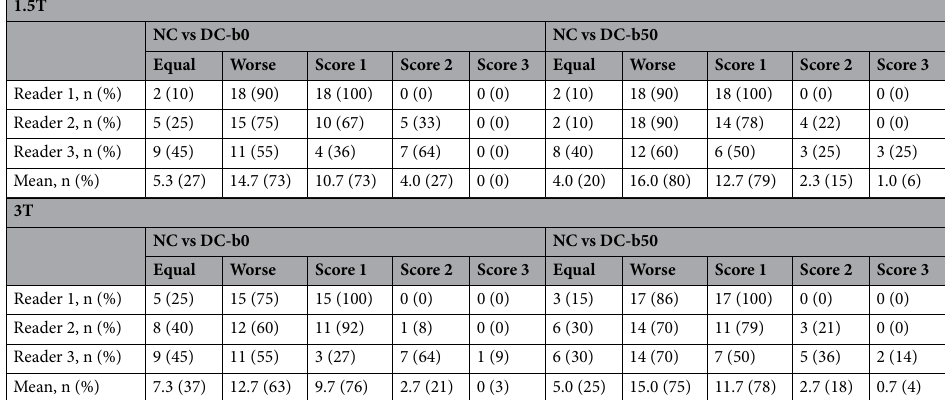
Table 4. Rating and scores given by three radiologists when comparing the image quality of non-corrected and distortion corrected axial b50 images side by side. The number of distortion corrected scans scored as ‘equal’ or ‘worse’ compared to the corresponding non-corrected scans are shown for DC-b0 and DC-b50 data. The scores given for scans marked as having worse image quality are also shown. The mean rating and score for the three readers’ assessments are indicated. In parentheses, percentages are given. NC non-corrected, DC- b0 b0-based distortion correction, DC-b50 b50-based distortion correction.